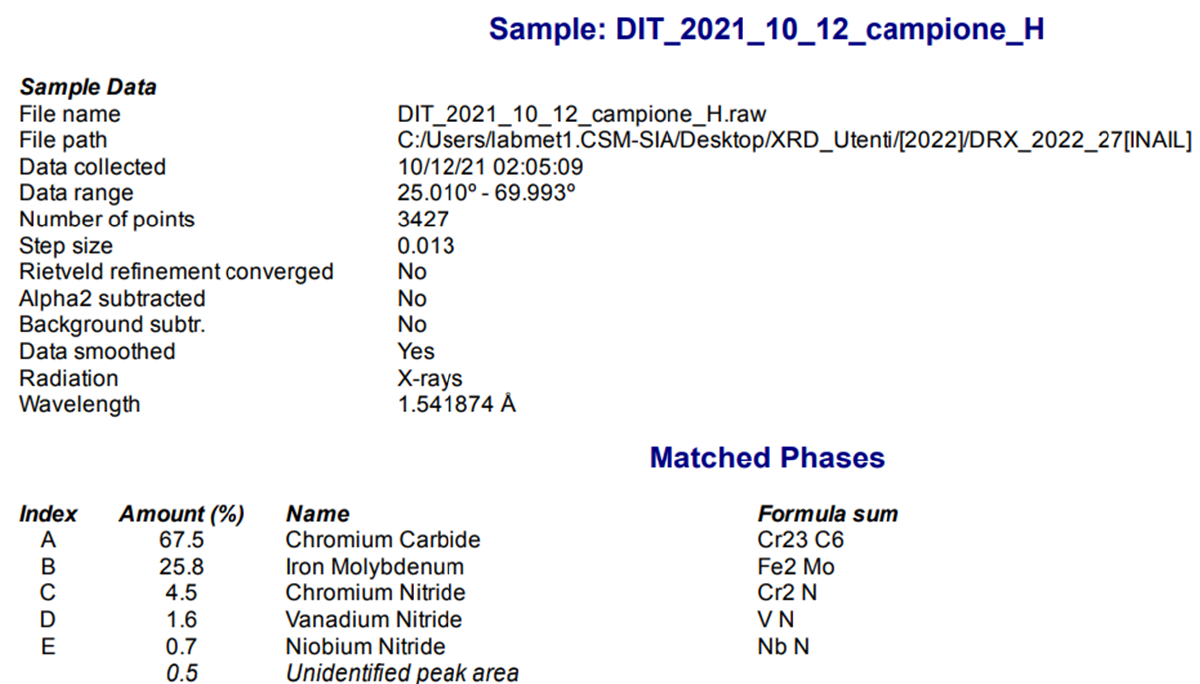
Figure A12. Failed crept cross-weld specimen 92-HAZ-6-6 650 °C 65 MPa 3877 h (sample H). Sample data and matched phases.